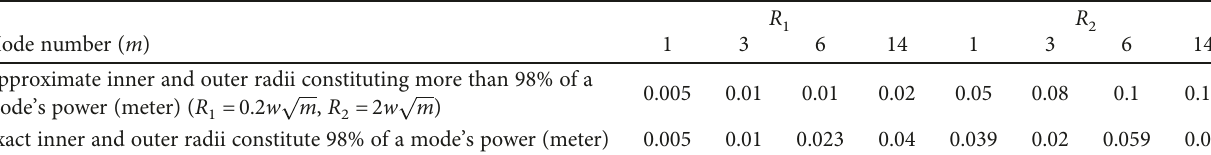
Table 1: Exact and approximate radii of modes.